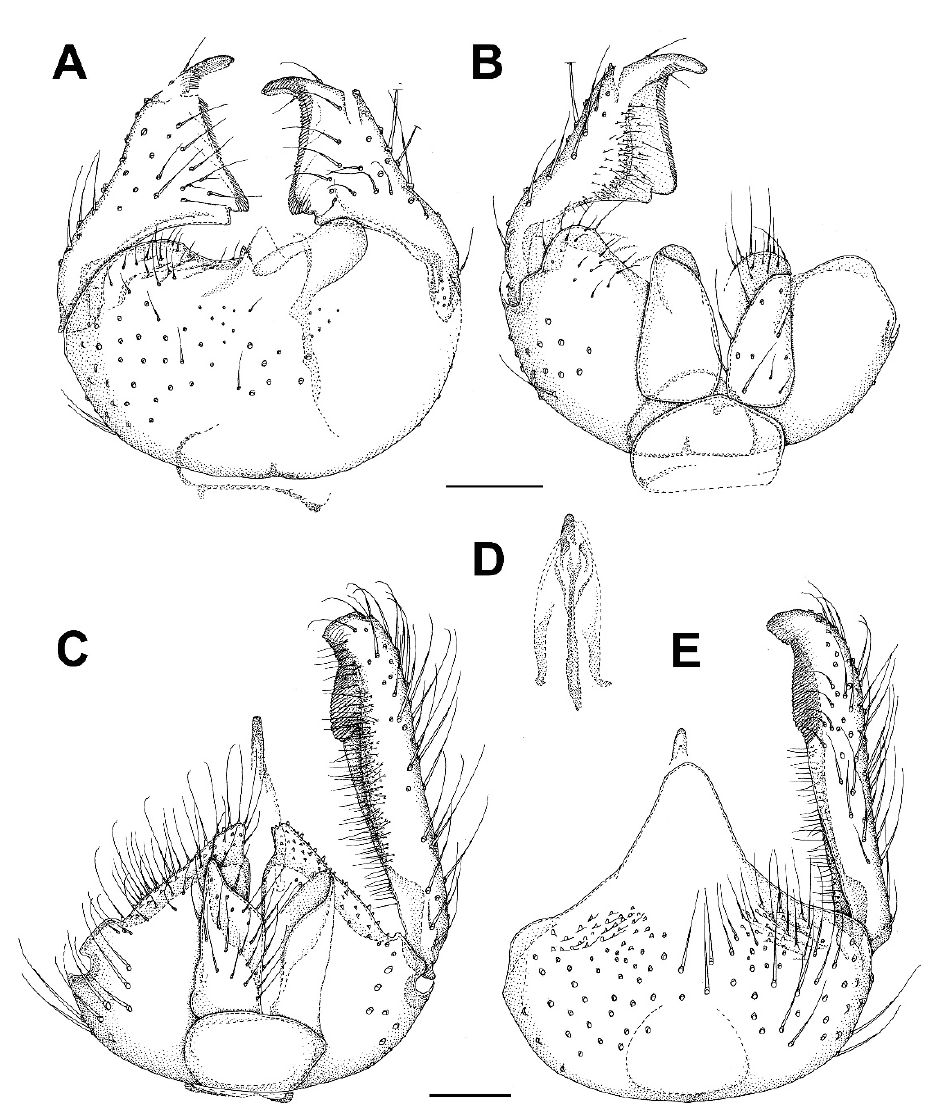
Figure 11. Male terminalia of Ditomyiidae. Celebesomyia inocellata Saigusa, ( A ) ventral view, ( B ) dorsal view; Ditomyia asiatica sp. nov. (holotype), ( C ) dorsal view with cerci, ( D ) aedeagus in ventral view, ( E ) ventral view. Scale bars: 0.1 mm.